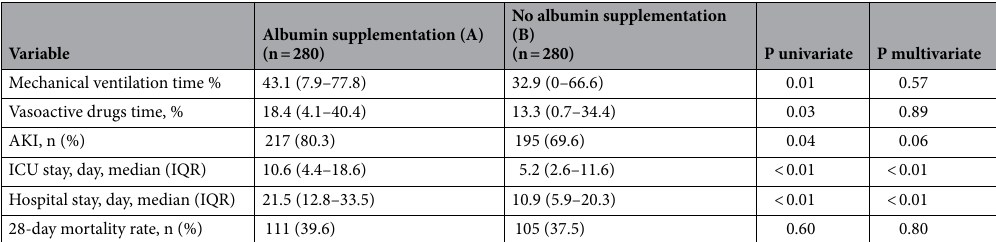
Table 5. The effect of albumin supplementation for hypoalbuminemia on the results of the study. In multivariate regression analysis, possible influencing factors (including BMI, septic shock, blood sodium on admission, vasoactive drugs, and mechanical ventilation) were